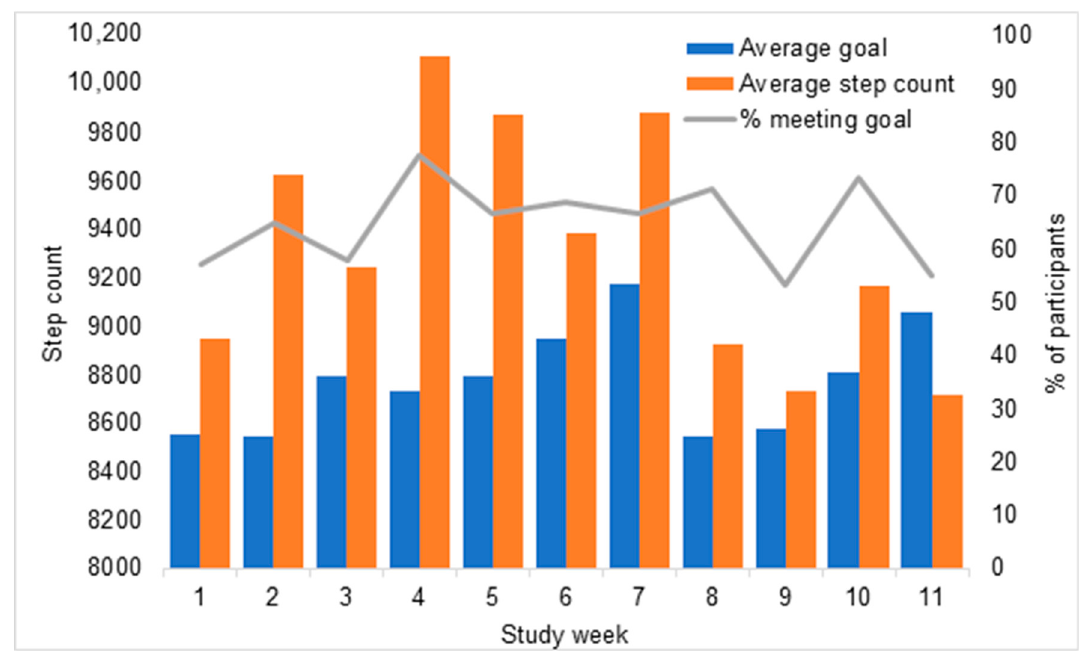
Figure 4. Mean step count, mean step goal, and the percentage of participants who met their goal, by week.